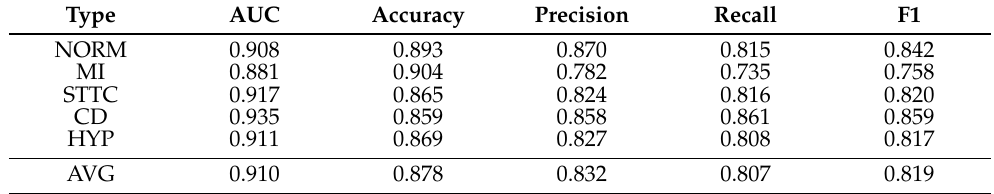
Table 8. Results produced by the proposed model without the CoT block on the PTB-XL dataset.